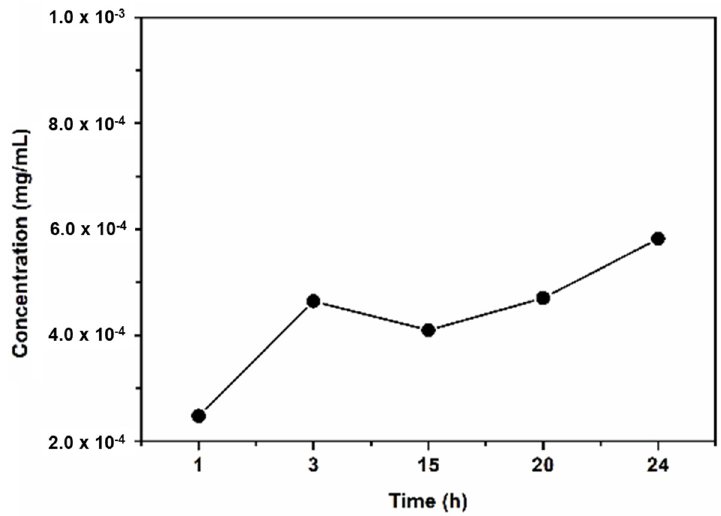
Figure 6. Concentrations of AZPY released from 0.5 mg of Cu(AZPY)-MOF in 1 mL of PBS.